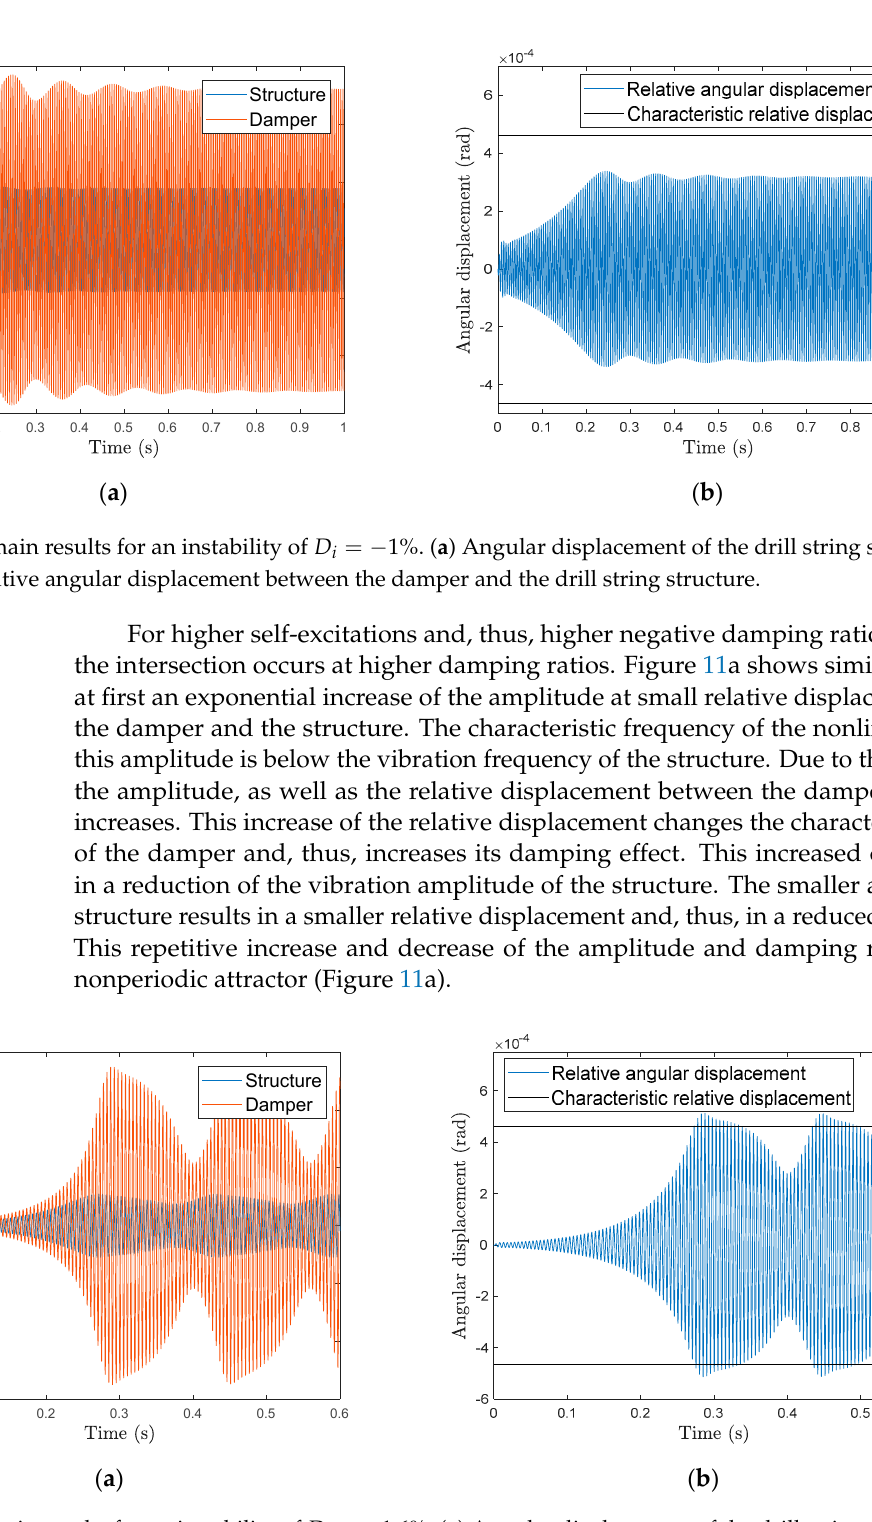
( b ) Figure 9. Damper with a cubic nonlinear stiffness ( (cid:2009) = 7 ∙ 10 (cid:2869)(cid:2869) (cid:1840)(cid:1865),(cid:1856) = 50 (cid:3015)(cid:3040) (cid:3046) ,(cid:2033) (cid:2868) = 1000 (cid:2869) (cid:3046) , Ω = 1250 (cid:2869) (cid:3046) , (cid:1836) = 0.2 (cid:1863)(cid:1859)(cid:1865) (cid:2870) ). ( a ) Equivalent damping ratio regarding the angular displacement of the underlying structure. ( b ) Relative angular displace- ment regarding the angular displacement of the underlying structure. For the smallest instability—thus, a linearized negative damping ratio of (cid:1830) (cid:3036) = −1% —the self-excited oscillation is limited and, thus, stabilized by the damping effect of the nonlinear damper. Due to the nonlinear stiffness and the frequency difference between the linear natural frequency of the damper and the vibration frequency of the structure, the damping effect is sufficient to stabilize the system above a certain amplitude. There- fore, at small amplitudes, the amplitude increases exponentially, as usual in self-excited